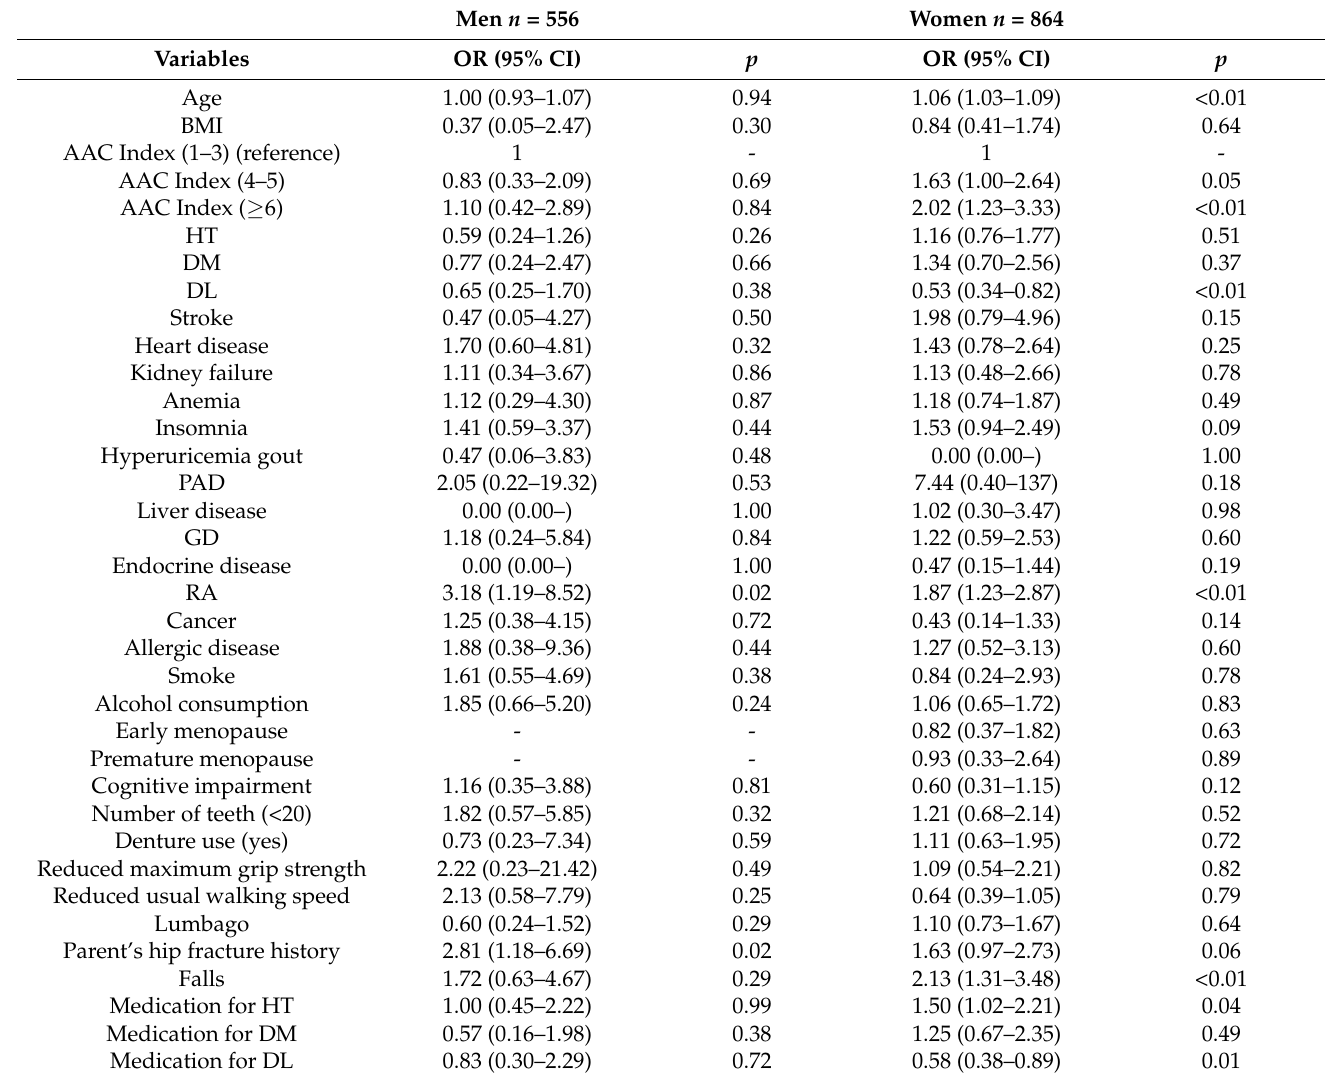
Table 2. Odds ratios for fragility fracture in men and women by binary logistic regression.